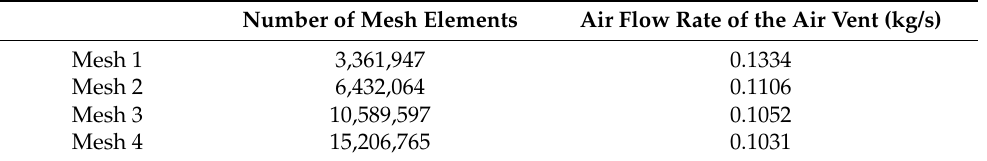
Table 5. Mesh independence